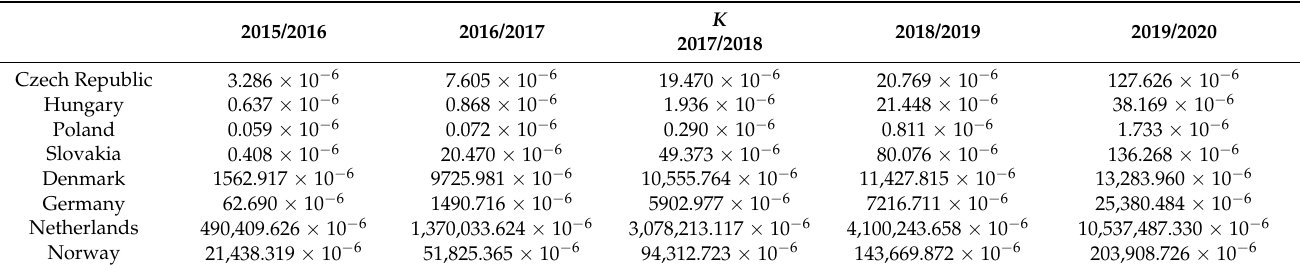
Table 11. Values of the infrastructural country electromobility coefficient ( K ) for selected European countries at the turn of the years.